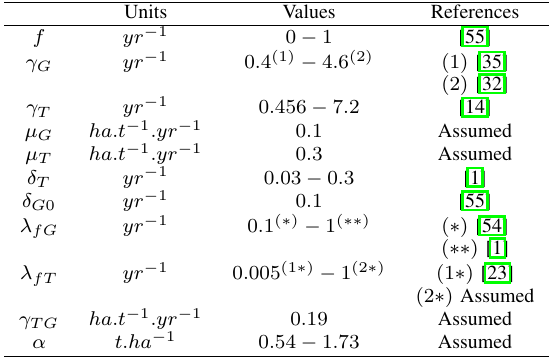
Fig. 7: Stability/instability properties of equilibria when R and ω ( G e ) R 10 > 1 . Stable equilibria are shown with solid circles; unstable equilibria are shown with open circles. Opposite to Fig 1 , there are three internal equilibria where the null clines meet. The intermediate equilibrium point is unstable and the lower and upper equilibria are stable. A separatix which divides the plane into two basins of attraction passes through the unstable equilibrium. Depending on the initial condition, trajectories will evolve either to the left or right (bistability).